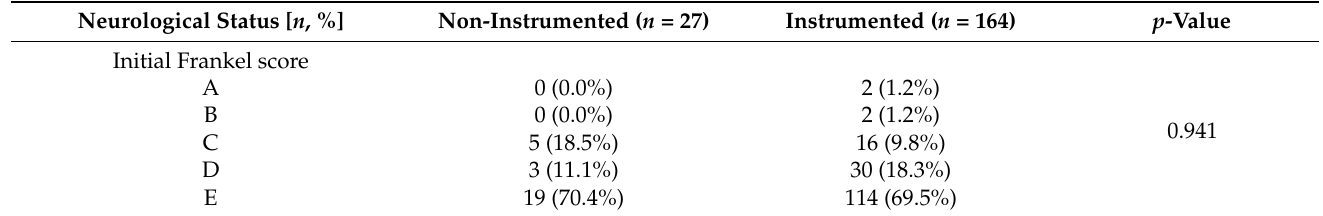
Table A5. Frankel score and ambulatory status in instrumented and non-instrumented patients with SINS 10 to